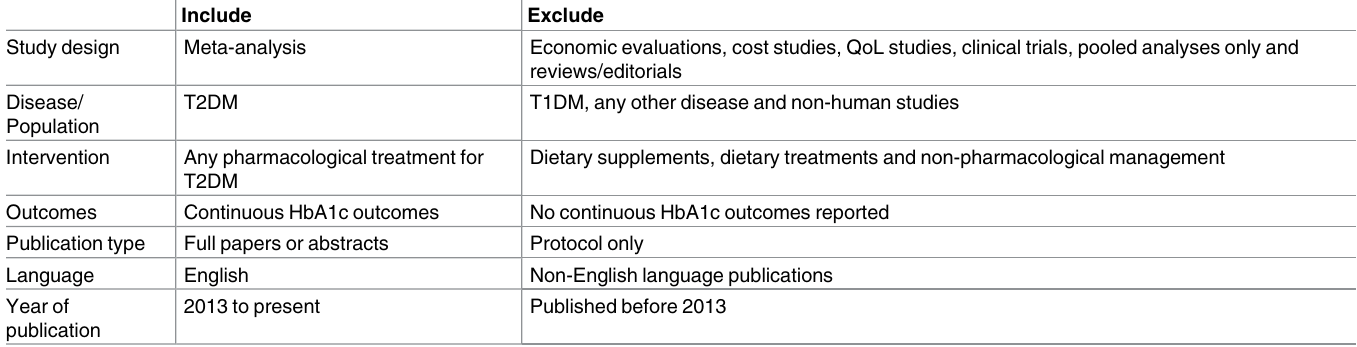
Table 1. Inclusion and exclusion